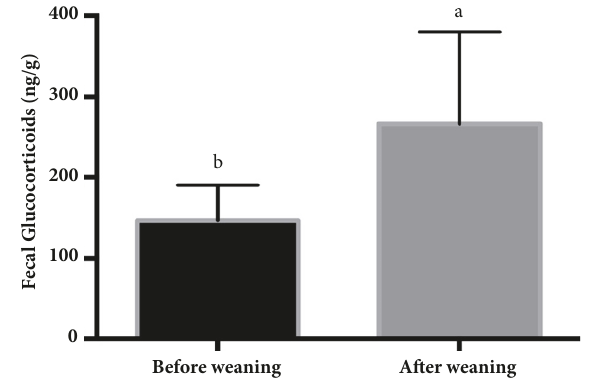
Figure 4: Comparison of fecal glucocorticoid metabolite concen- trations (mean ± SD) between preweaning and postweaning sows. a , b Significant difference ( P < 0.05 ). ∗ Statistical significance ( P < 0.05 ) between